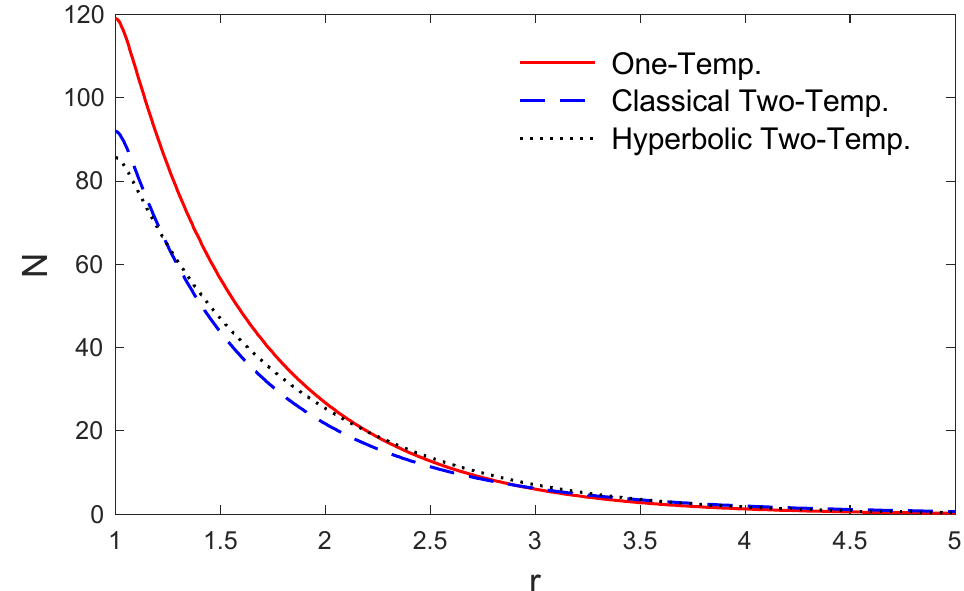
Figure 3. The variation of carrier density with distance for different models. Mathematics 2020 , 8 , x